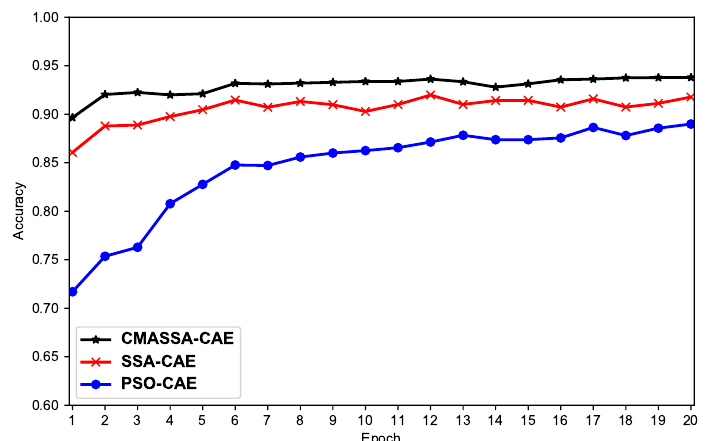
Figure 9. The accuracy of each optimization algorithm on the classification task.